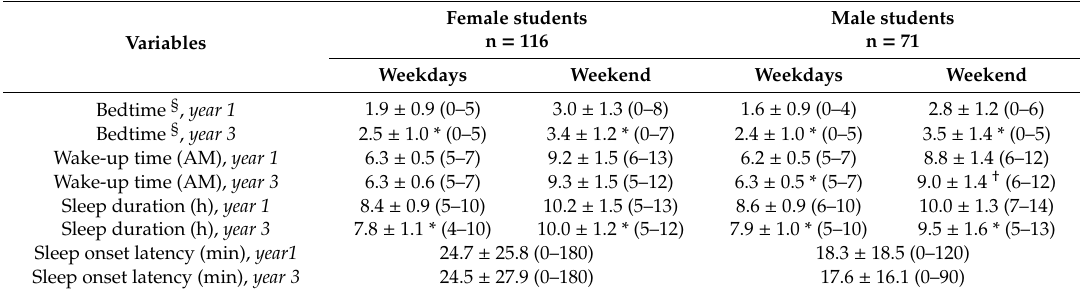
Table 3. Sleeping habits on weekdays and weekends of high school female and male